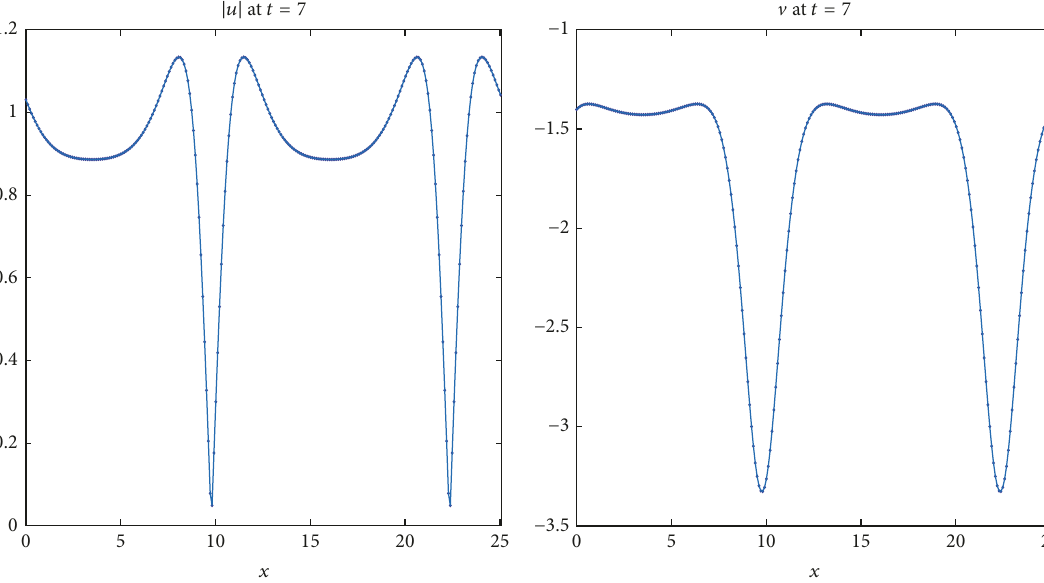
Figure 2: Evolution of the travelling wave solution (39) (with 𝜙,𝜓 as in Figure 1) of the SBO system at 𝑡 = 7 . In solid line, |𝑢|, V computed with the numerical solver introduced in [14]. In pointed line, |𝑢|, V for the approximate travelling wave solution (39).